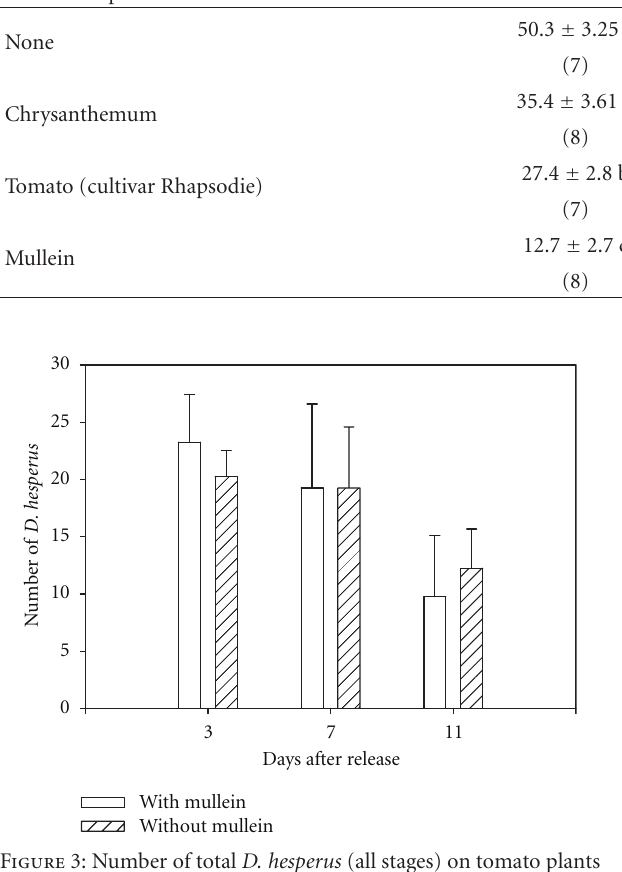
Figure 3: Number of total D. hesperus (all stages) on tomato plants in greenhouses in the presence or absence of mullein banker plants and the absence of prey. Values are means ± SE, and N = 4 for each bar.